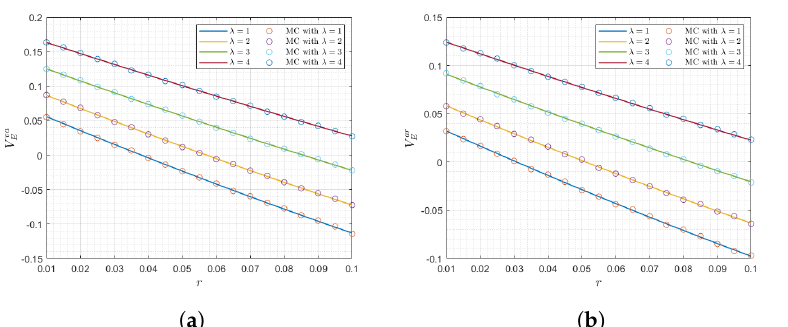
Figure 7. Valuations of IRSs V ar and a notional principle P = 1. ( a ) Arrears swaps V ar